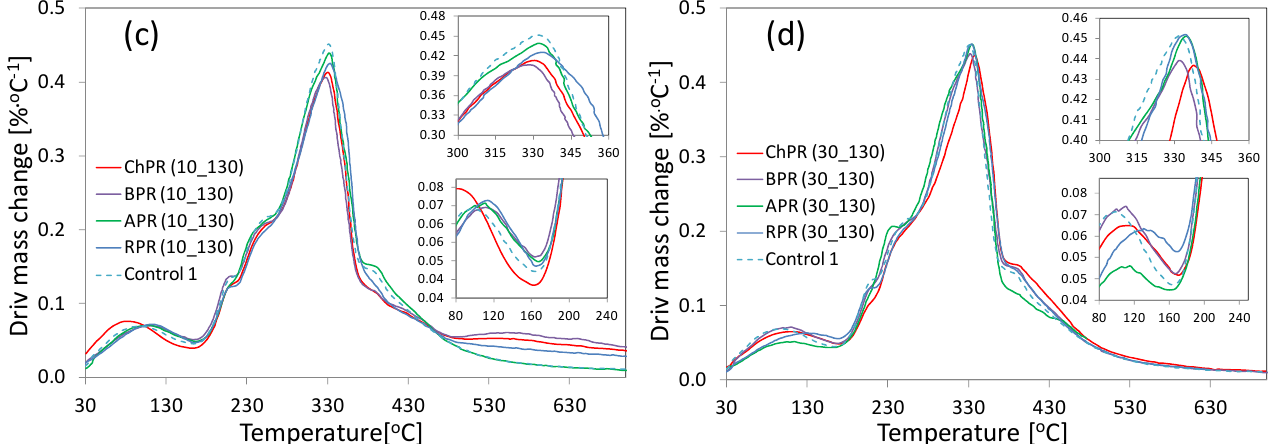
Figure 7. Thermogravimetric analyses of biocomposites: ( a ) mass loss of biocomposites containing 10 wt% of pomace, ( b ) mass loss of biocomposites containing 30 wt% of pomace, ( c ) derivative mass change of biocomposites containing 10 wt% of pomace, ( d ) derivative mass change of biocomposites containing 30 wt% of pomace.